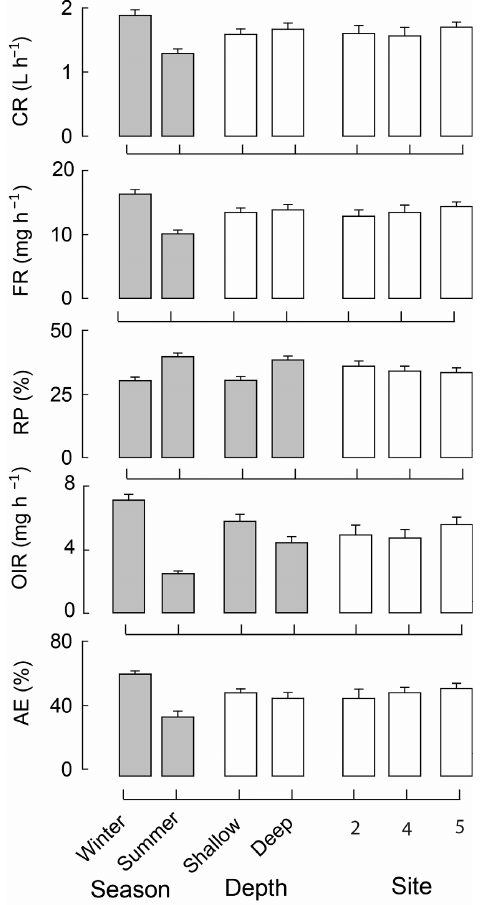
Figure 4. Mean (+SE) feeding parameters of Mytilus galloprovincialis during winter and summer and in shallow and deep waters at three sites of the Swan-Canning Estuary. CR is clearance rate, FR filtration rate, RP rejection proportion, OIR organic ingestion rate, and AE absorption efficiency. Bars were shaded grey when levels within each factor were statistically significant from each other. There was a significant positive relationship between FR of M. galloprovincialis and POM of estuary water (FR = 2.52 POM + 3.75; p = 0.026, r = 0.64, Figure 5; Table 2). Rejection proportion was negatively related to POM (RP = − 5.16 POM + 54.04, p < 0.001, r = − 0.86) Table 2. p -values (two-tailed) for relationships between Swan-Canning Estuary water parameters and and positively related to PIM (RP = 5.45 PIM + 10.01, p = 0.013, r = 0.69). Organic ingestion Mytilus galloprovincialis feeding parameters. Pearson’s r values are reported for p < 0.05. TPM